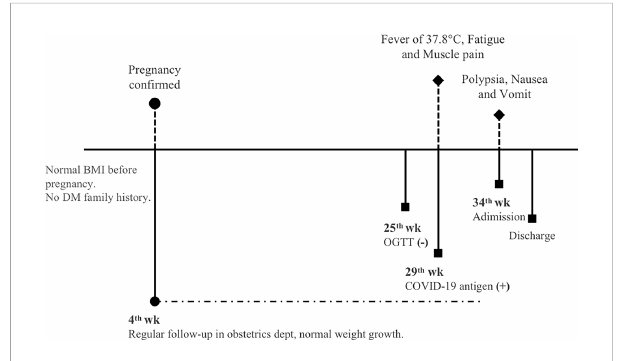
FIGURE 1 Timeline of events and important information of this